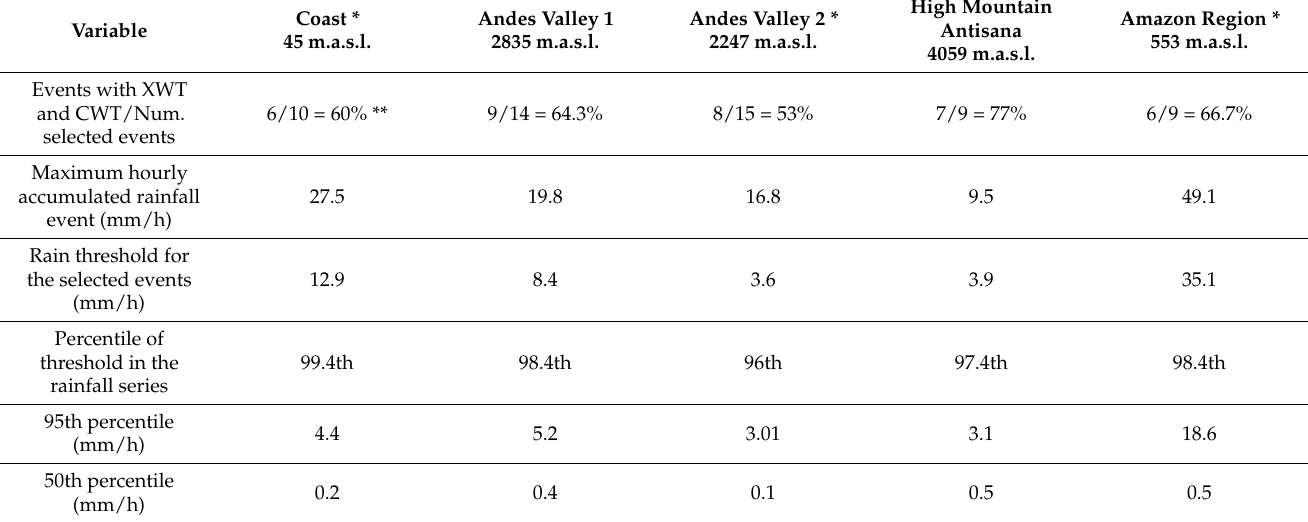
Table 4. Characteristics of selected events of interest. * Points the series with data from 21 July to 31 December 2014. ** Indicates that the six chosen events correspond to the most intense as